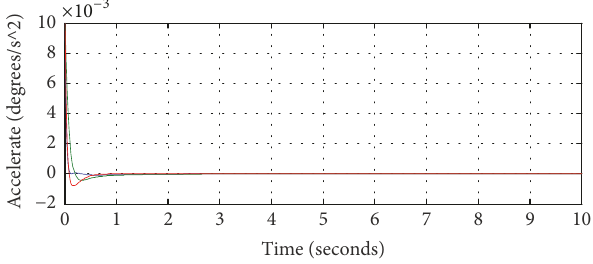
Figure 14: Disturbance observer errors in angle_rate dynamic.